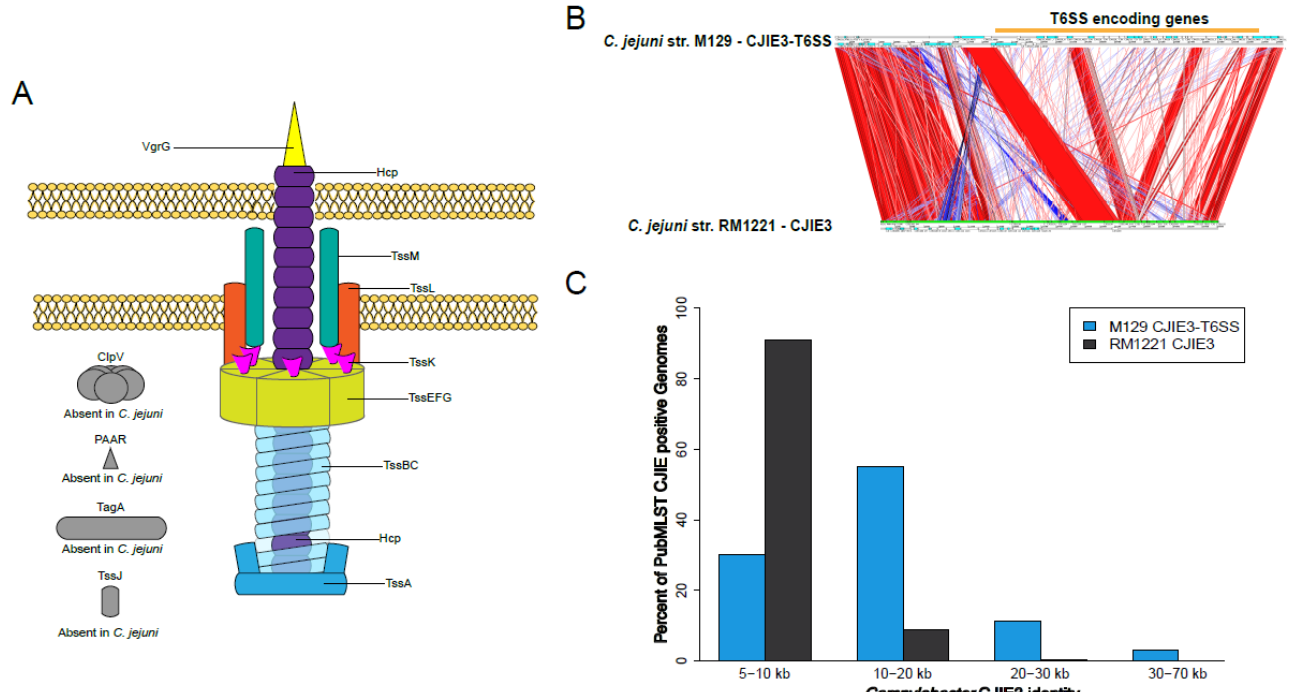
Figure 6. Components of the type VI secretion system (T6SS) identified in C. jejuni . Panels: ( A ) Iden- tification of C. jejuni homologs to the structural components of Gram-negative T6SS; all components are present except for ClpV, PAAR (tip of the T6SS needle), TagA (functions to stop assembly of the tail), and TssJ (membrane complex) [an alternative model has been published by Cherrak et al. [208]]. ( B ) Alignment comparison of CJIE3 from C. jejuni strain RM1221 to C. jejuni strain M129 that contains the T6SS; red demonstrates regions present in M129 CJIE3 that are also present in RM1221 CJIE3 and vice versa for blue. The region containing T6SS encoding genes is marked above the M129 CJIE3 region. ( C ) Percentage of the approximately 13,000 Campylobacter genomes in the PubMLST database that contain CJIE3 based on the size of the hit identity for the element for the two different CJIE3s with or without the T6SS genes.